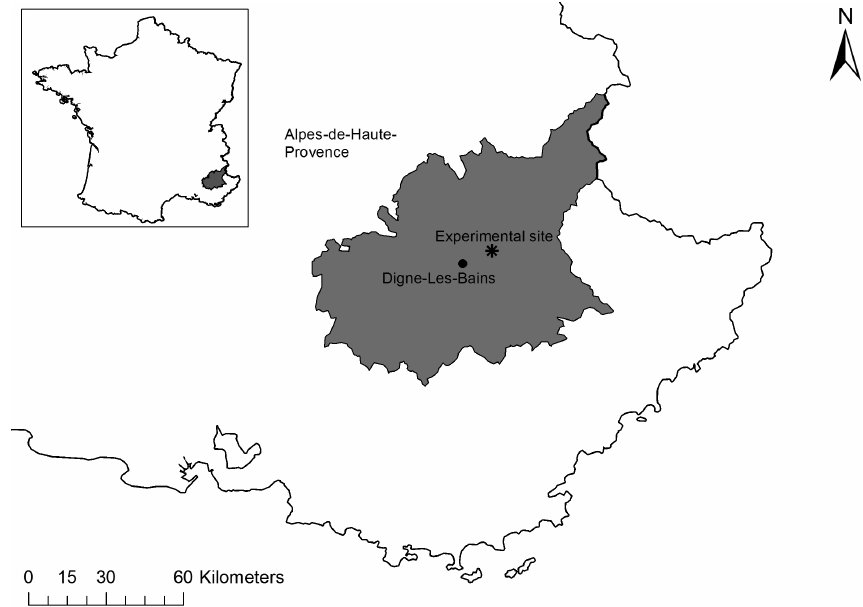
Figure 1. Location of the experimental